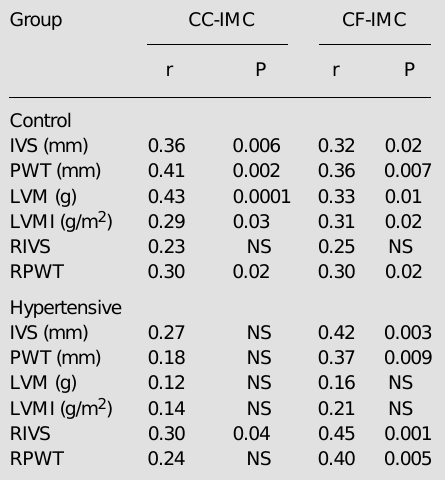
Table 5 - Spearman correlation coefficient between common carotid (CC)- and common femural (CF)- intima-media complex (IMC) and cardiac param- eters in control and hypertensive